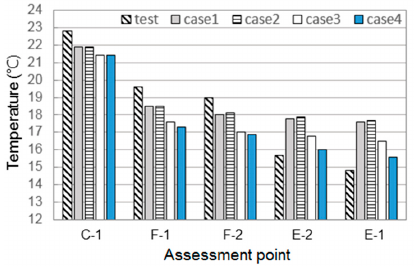
Figure 8. Measured and calculated temperatures at each assessment point.